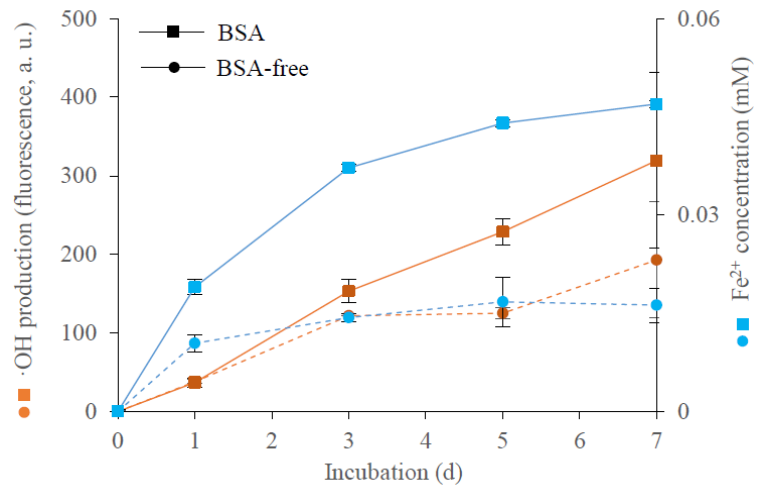
Figure 1. Production of extracellular hydroxyl radicals ( • OH) and reduction of Fe 3+ by P. involutus when grown for 7 days on BSA-containing and BSA-free media. Reduction of Fe 3+ was estimated as the concentration of Fe 2+ in the culture filtrate. Bars indicate ± standard deviations ( n = 3).